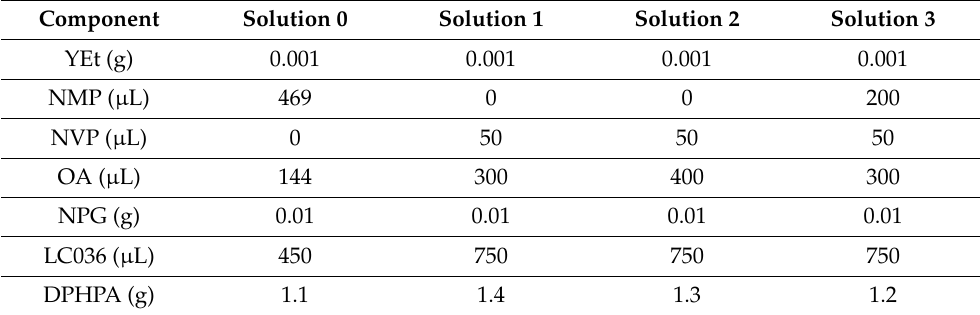
Table 1. Chemical compositions analyzed.